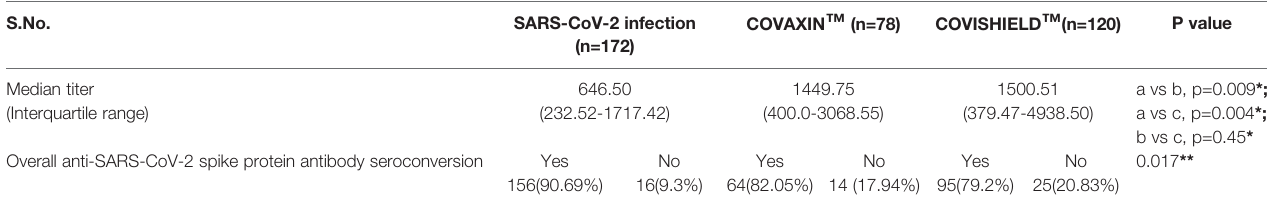
$- Indicates seroconversion in patient who had anti SARS-CoV-2 Spike protein antibody titer >50AU/ml. * Kruskal Wallis Test; **Chi Square test.